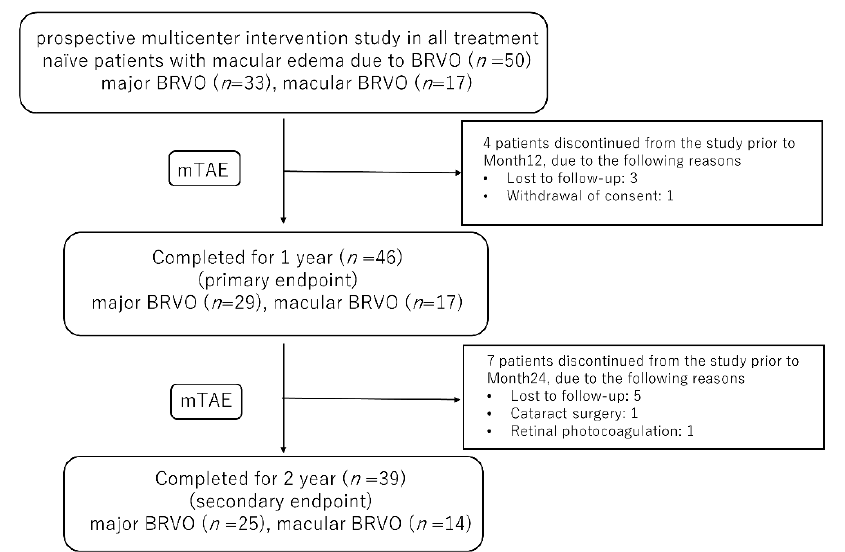
Figure 1. The study design and patient disposition. BRVO, branch retinal vein occlusion, mTAE, modified treat-and-extend.